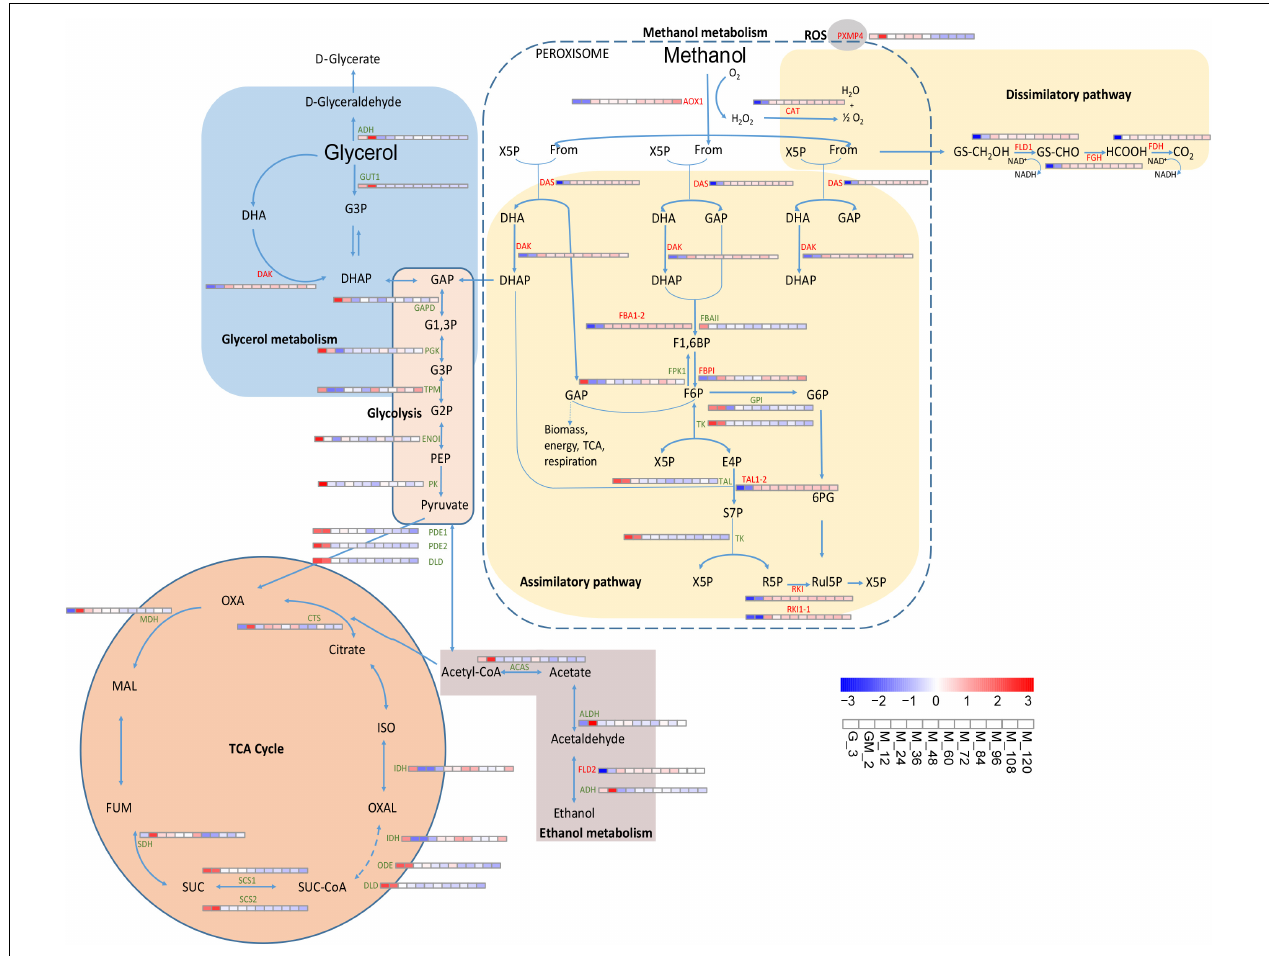
FIGURE 3 | Changes in proteins involved in carbon metabolism and oxidative stress metabolic pathway. Rußmayer et al. (2015) was the first study to report that the methanol assimilation pathway localized to